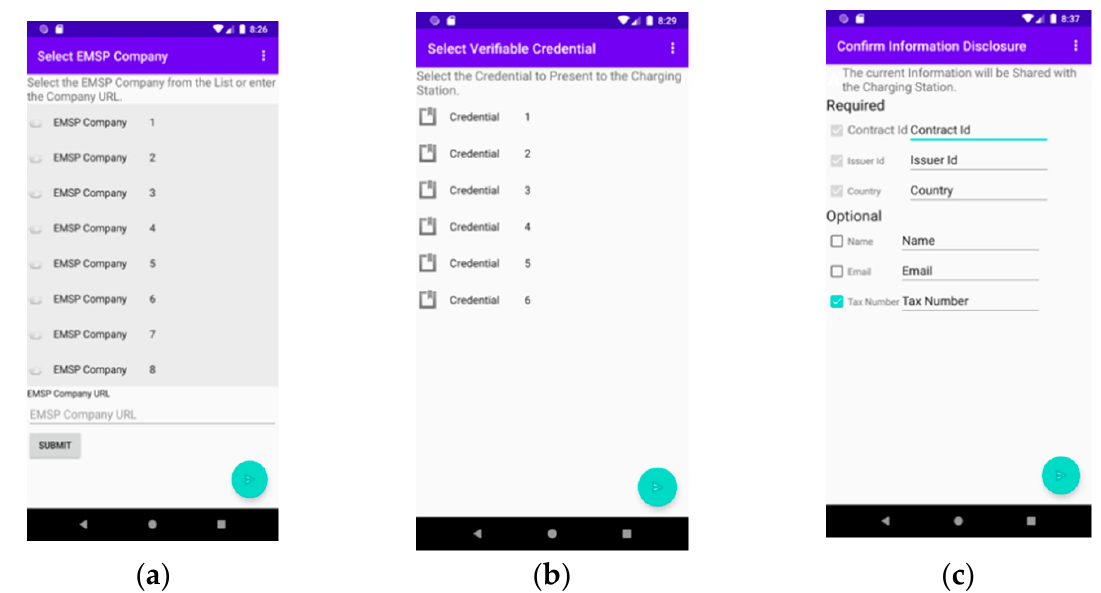
Figure 7. The EVO mobile app screenshots. ( a ) Selection of provider company for registration. ( b ) Selection of verifiable credential. ( c ) Accepting disclosure information.